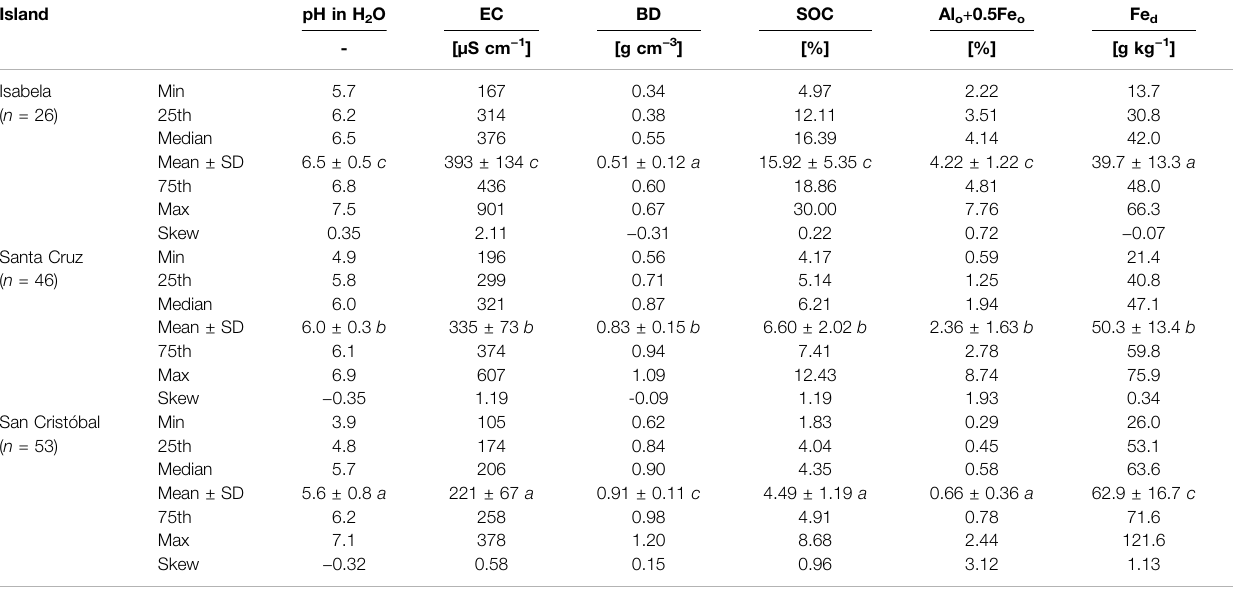
TABLE 1 | Descriptive statistics (minimum, 25th percentile, median, mean ± standard deviation, 75th percentile, maximum, skewness) of key soil properties on the three studied islands.